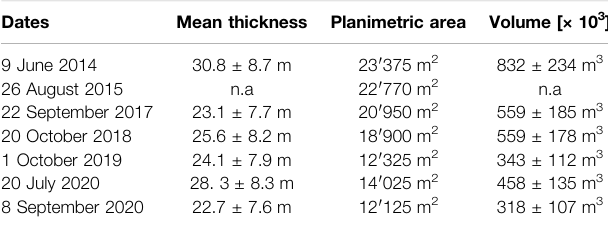
TABLE 2| MorphologicalevolutionoftheunstablesectoroftheMontitazlobe(n.a.= not available).